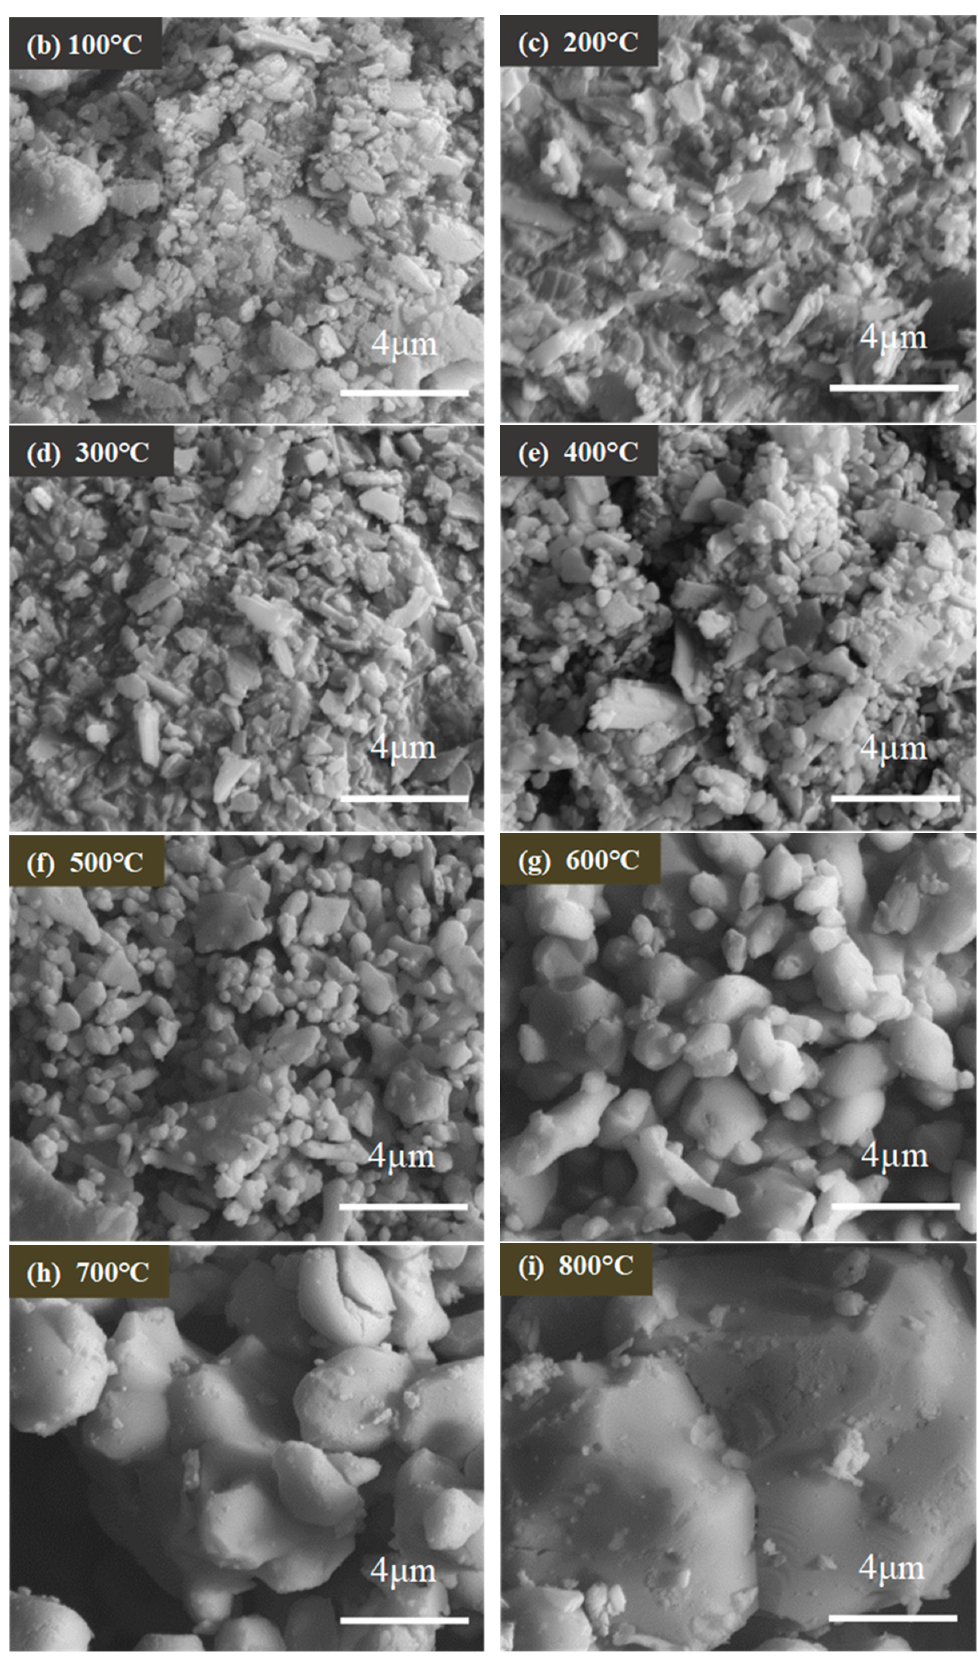
Figure 5. Micrographs of shell powders calcined at different temperatures.